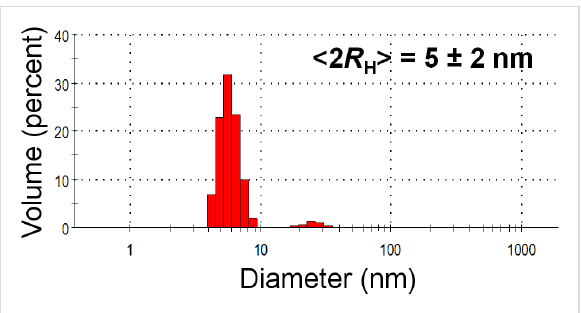
Figure 4: DLS of the AgNP-3MPS solution (synthesis b). The hydrody- namic diameter was <2 R H > = 5 ± 2 nm.